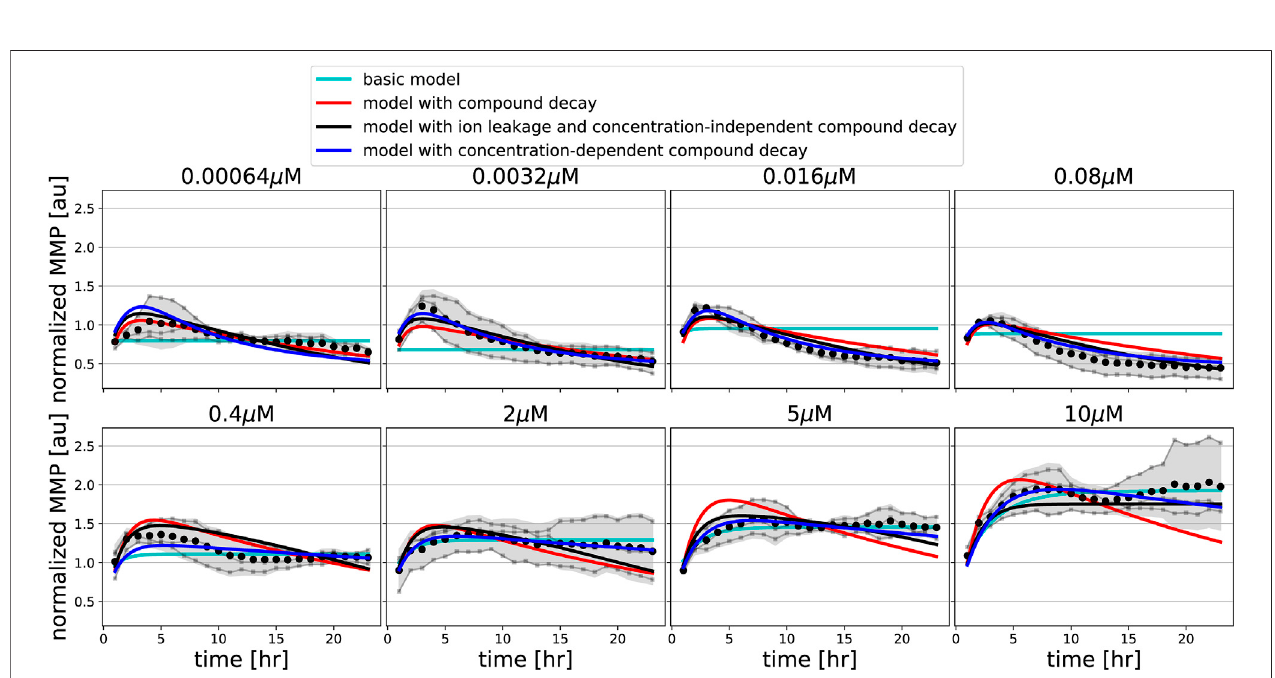
FIGURE 6 | Model extension with ion leakage and/or compound decay improves the description of oligomycin data. MMP data in response to various concentrationsofFCCP(graylineanddotsindicateindividualreplicates;blackdotsandshadingindicatesthemeanofreplicatesand95%con fi denceintervalsofmeans) are shown along with model simulations for best- fi tting parameters of the basic model (cyan lines), of the model extended with concentration-independent compound decay (red lines), of the model with ion leakage and concentration-independent compound decay (black lines), and of the model with concentration-dependent compound decay (blue